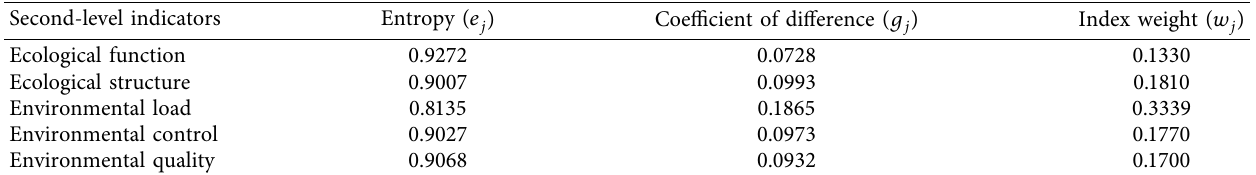
Table 4: The weights of the first-level indicators of the environmental quality assessment of the ecological conservation zone in Zhangjiakou